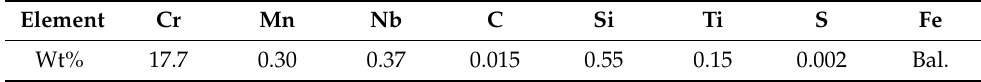
Table 1. Elemental composition of